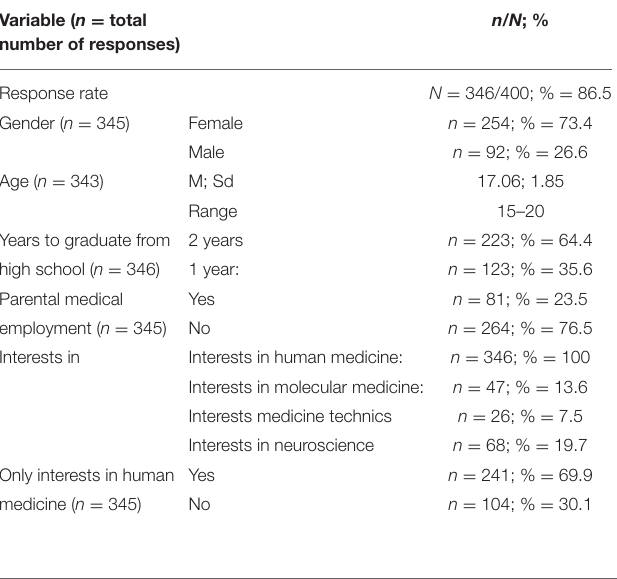
TABLE 2 | Characteristics of the study population and other variables.